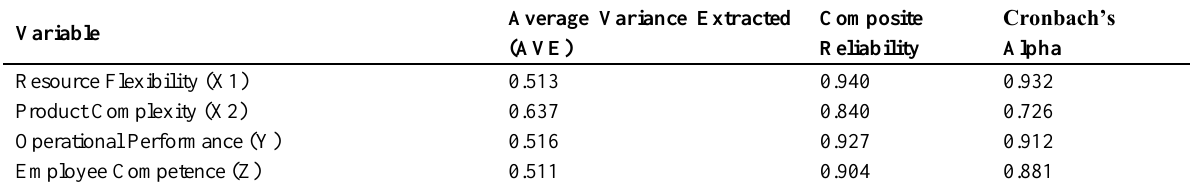
Table 2: Value of Average Variance Extracted, Composite Reliability, and Cronbach's Alpha